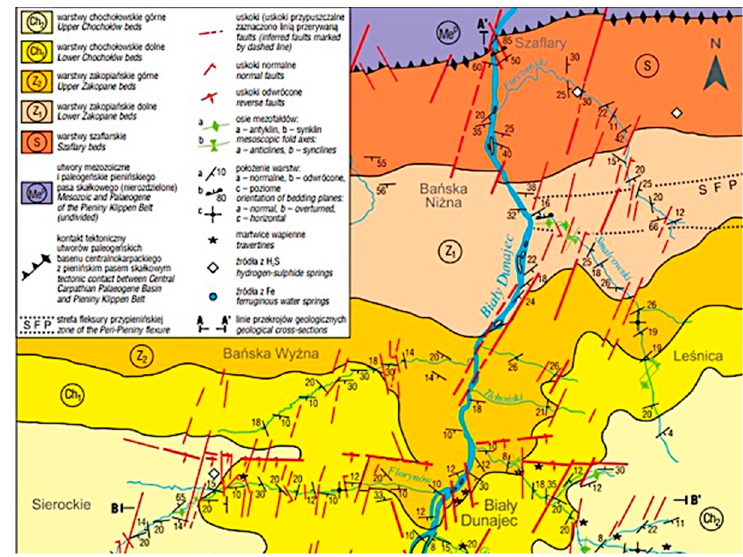
Figure 3. Geological map of the Carpathian Inner ‐ Mountain Basin [11].